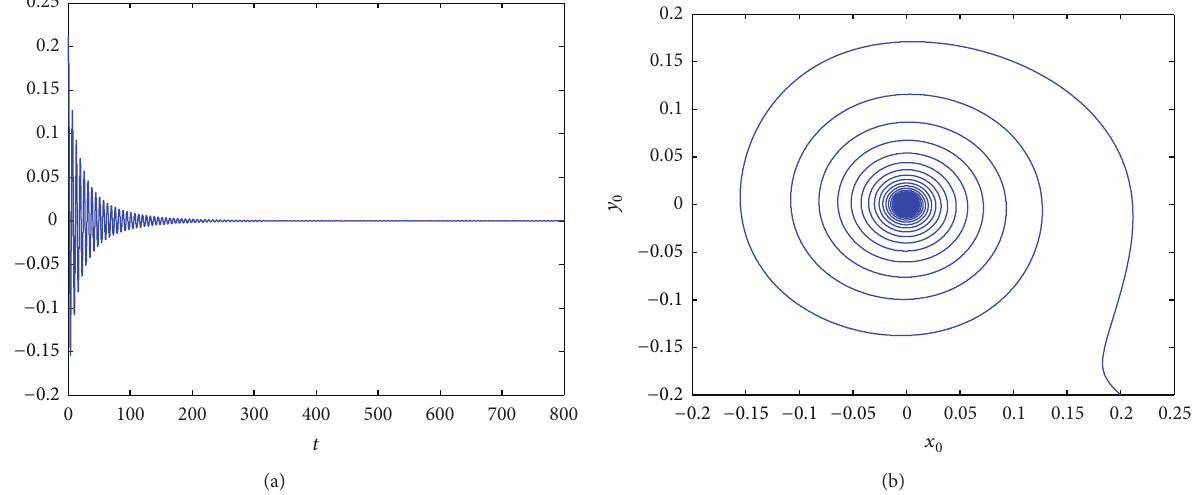
Figure 5: The time trajectory and phase diagram of EMR when 𝑡 ∈ [0, 800] . (a) The time trajectory. (b) The phase diagram in 𝑥 0 − 𝑦 0 plane.